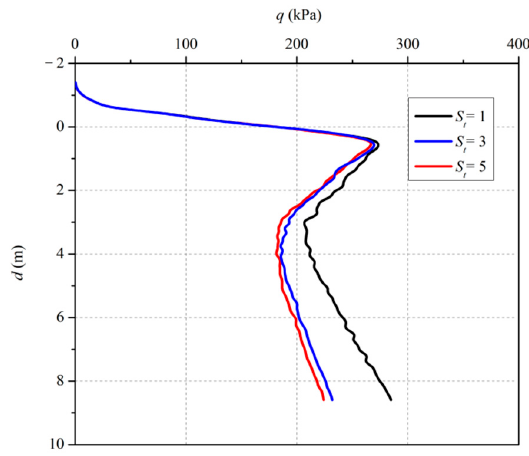
Figure 8. Penetration resistance profiles with different clay sensitivities.